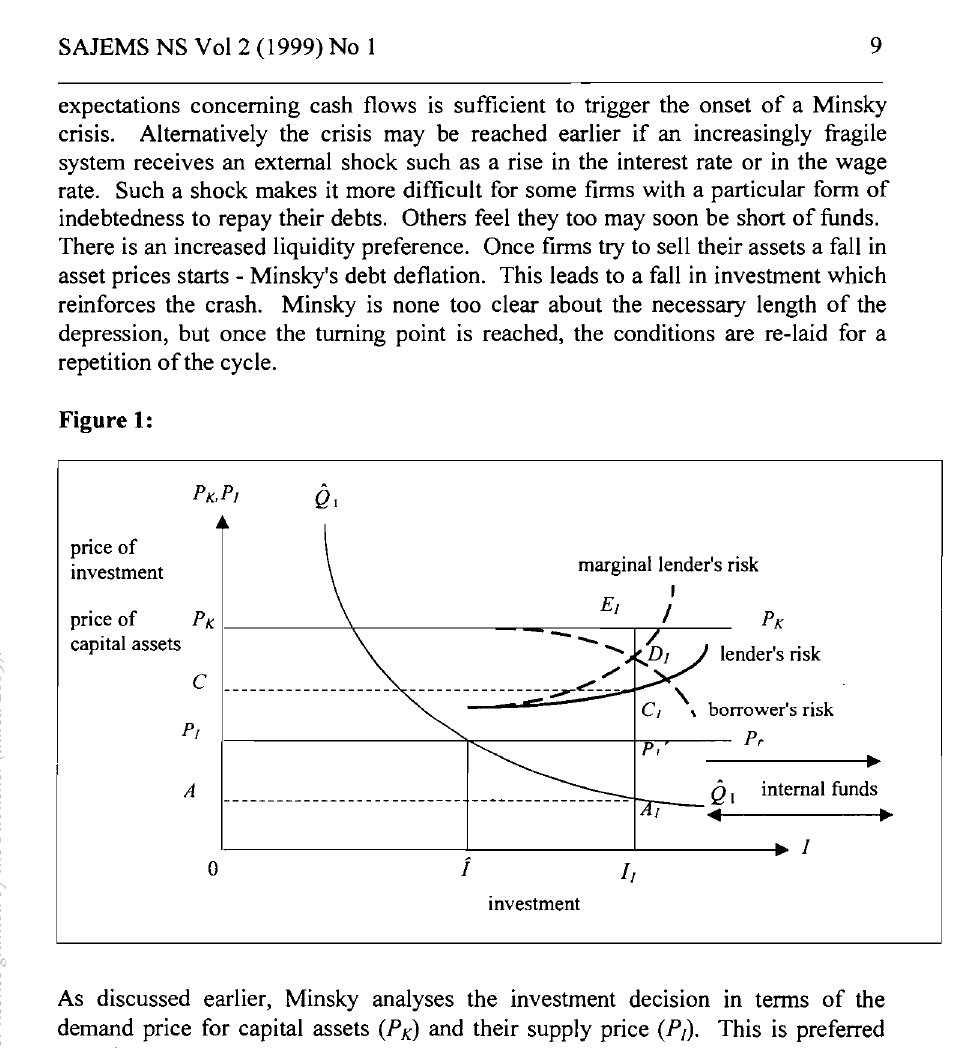
I internal funds